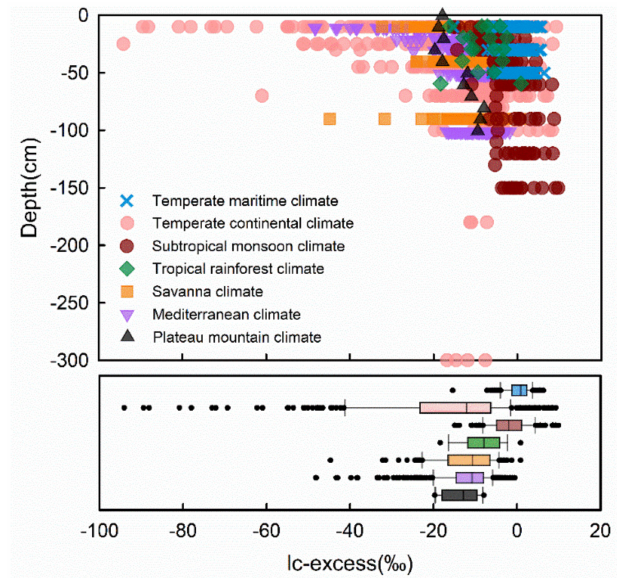
Figure 3. Trends of lc-excess values of soil water in di ff erent climate types with soil-depth. Data from